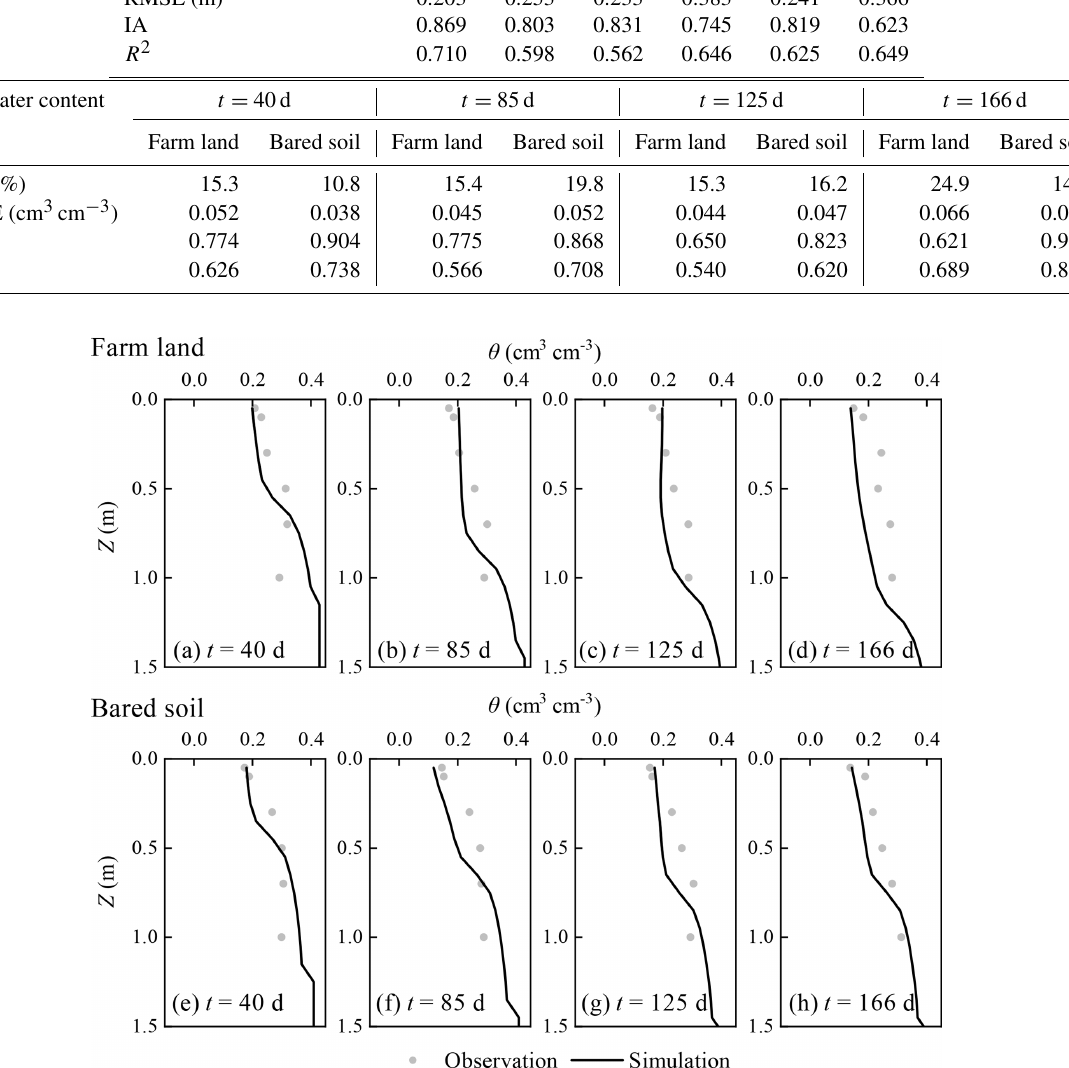
Figure 12. Comparison between simulated and observed regional average soil water content profiles of the real-world